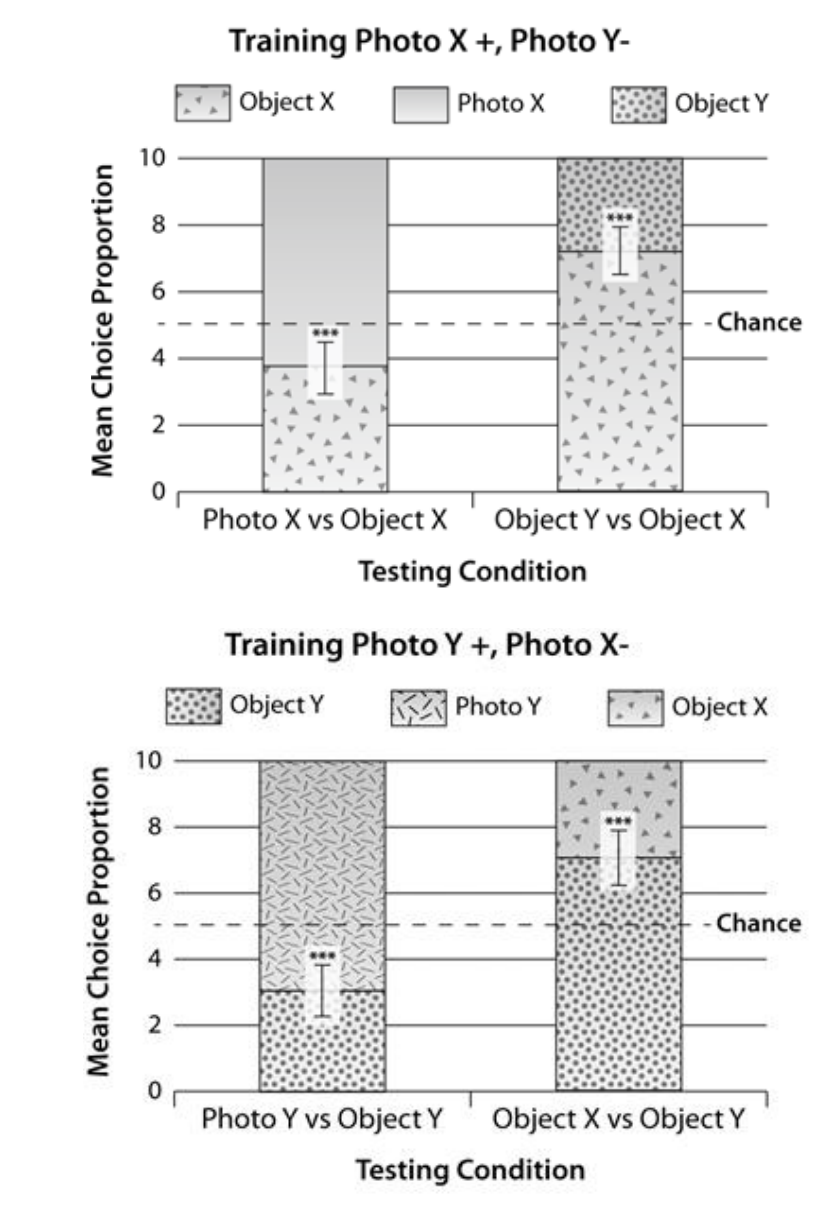
Figure 4 . Choice proportions with standard error bars for tests shown in Table 1 for two groups trained to discriminate between two photos of objects. (A) Photo X, shown in Figure 2, was rewarding, while Photo Y was unrewarding (B) Photo Y, shown in Figure 2, was rewarding, while Photo X was unrewarding. *** denotes a choice proportion significantly different from chance, p <